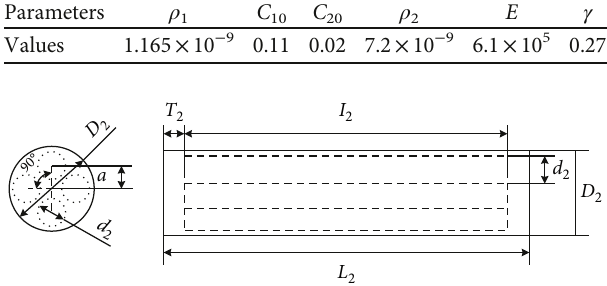
F IGURE 4: Design dimensional parameters of deformation section